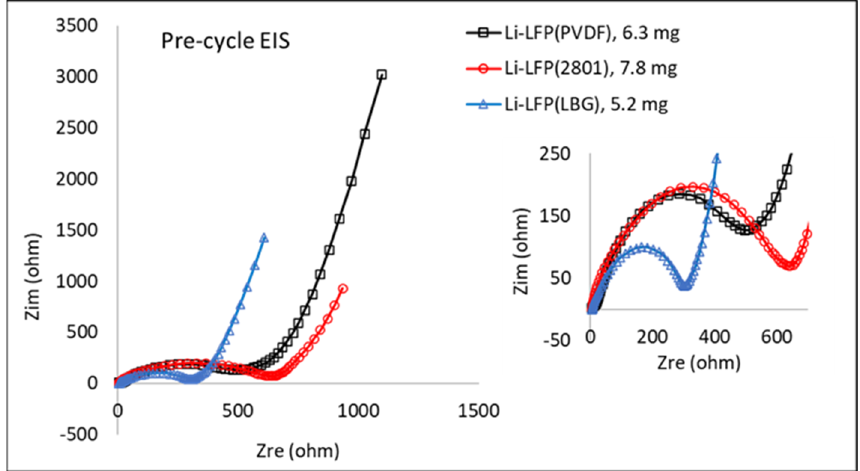
Figure 7. Nyquist plots from EIS tests of Li-LFP battery cells, after they have been fabricated and before any cycling, for LFP cathodes with different binders (PVDF binder; KynarFlex ® PVDF 2801-00 binder; Kynar PowerFlex ® LBG binder); the legend of each curve also gives the mass of the LFP coating (including additives).